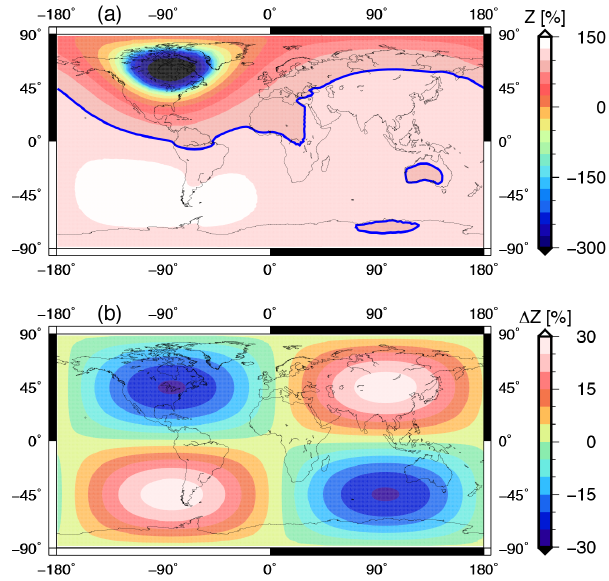
Figure B3. Rotational feedback to relative sea level. (a) Normal- ized sea level computed by ISSM-SESAW as in Fig. B2a, but with rotational feedback included. Notice the shape of Z = 100% (blue contours) with respect to the one drawn in Fig. B2a. (b) Difference between (a) and Fig. B2a, illustrating the (SH degree 2 order 1) signature of rotation induced sea-level